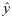
Experiment 1: Switching between a sine wave and the constant value 5.(A) Schematic of the experiment. Input consists of four streams: two cue channels u+ and u−, a sine wave usin, and the additional trained feedback signal dtf. First, feedback weights (orange) are learned by teacher forcing, followed by the feedforward weights (gray). Successful learning is achieved when the output signal d (magenta) matches its target value. (B) Comparison between the output signal (orange) and target value (blue) with (bottom) and without (top) trained feedback. (C) Scatter plots of the target signal y verses observed output y^ with (bottom) and without (top) trained feedback, and (D) their correlation coefficient for training (brown) and validation data sets (yellow).